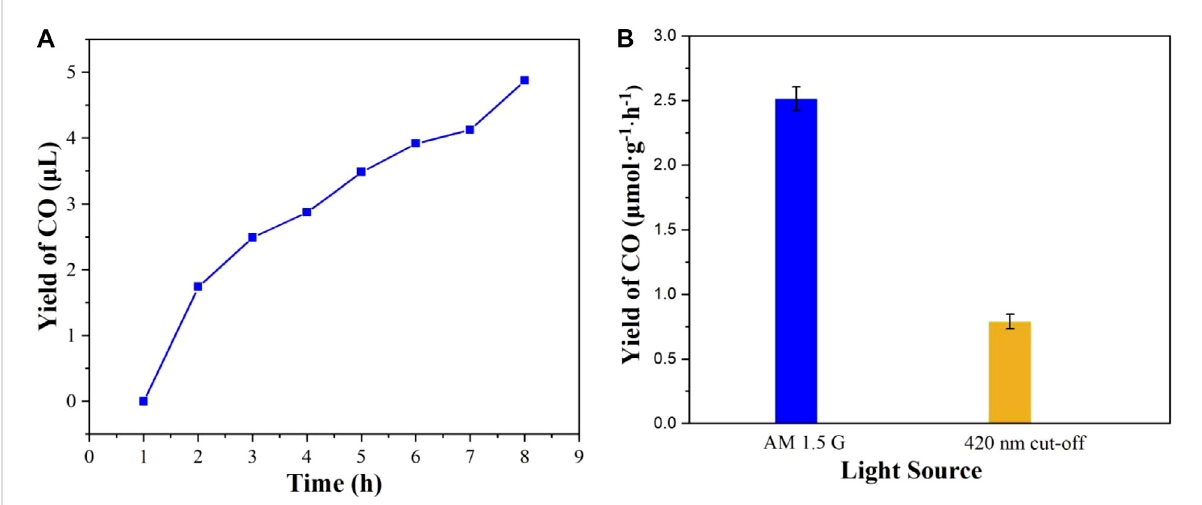
FIGURE 8 (A) The yields of CO reduced by CO 2 under AM 1.5 G illumination and (B) the yields rate of CO under different light source illumination.